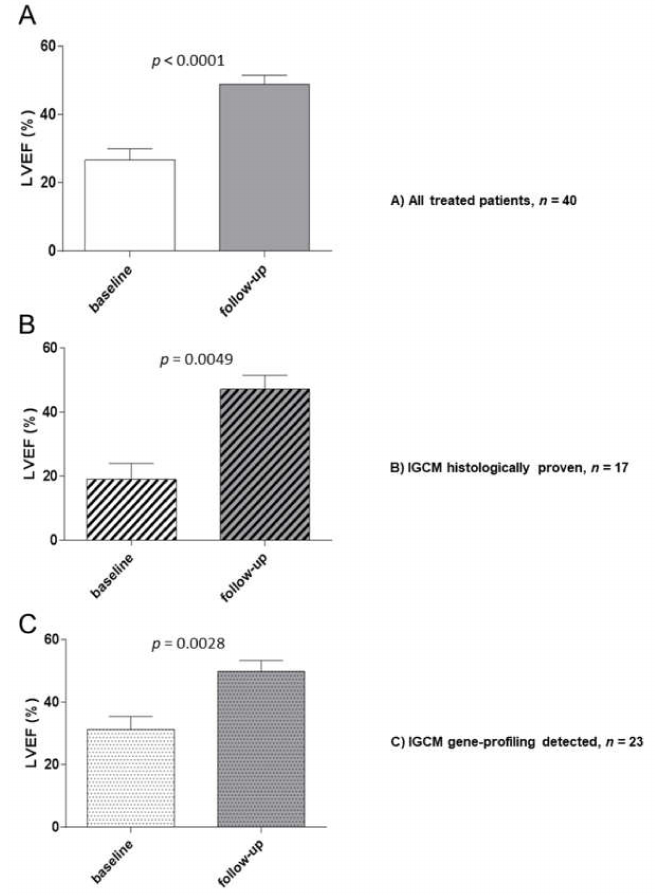
Figure 4. Baseline and Follow-up Hemodynamic Outcomes After Immunosuppressive Therapy for Patients with Histologically Proven or Gene-Profile-Detected IGCM. LVEF (%) was measured at baseline and during the follow-up period. ( A ) All treated patients. ( B ) Patients with histologically proven IGCM. ( C ) Patients with gene-profile-detected IGCM. The figures shown are mean values ± standard deviation; P -values compared to the baseline EMB are